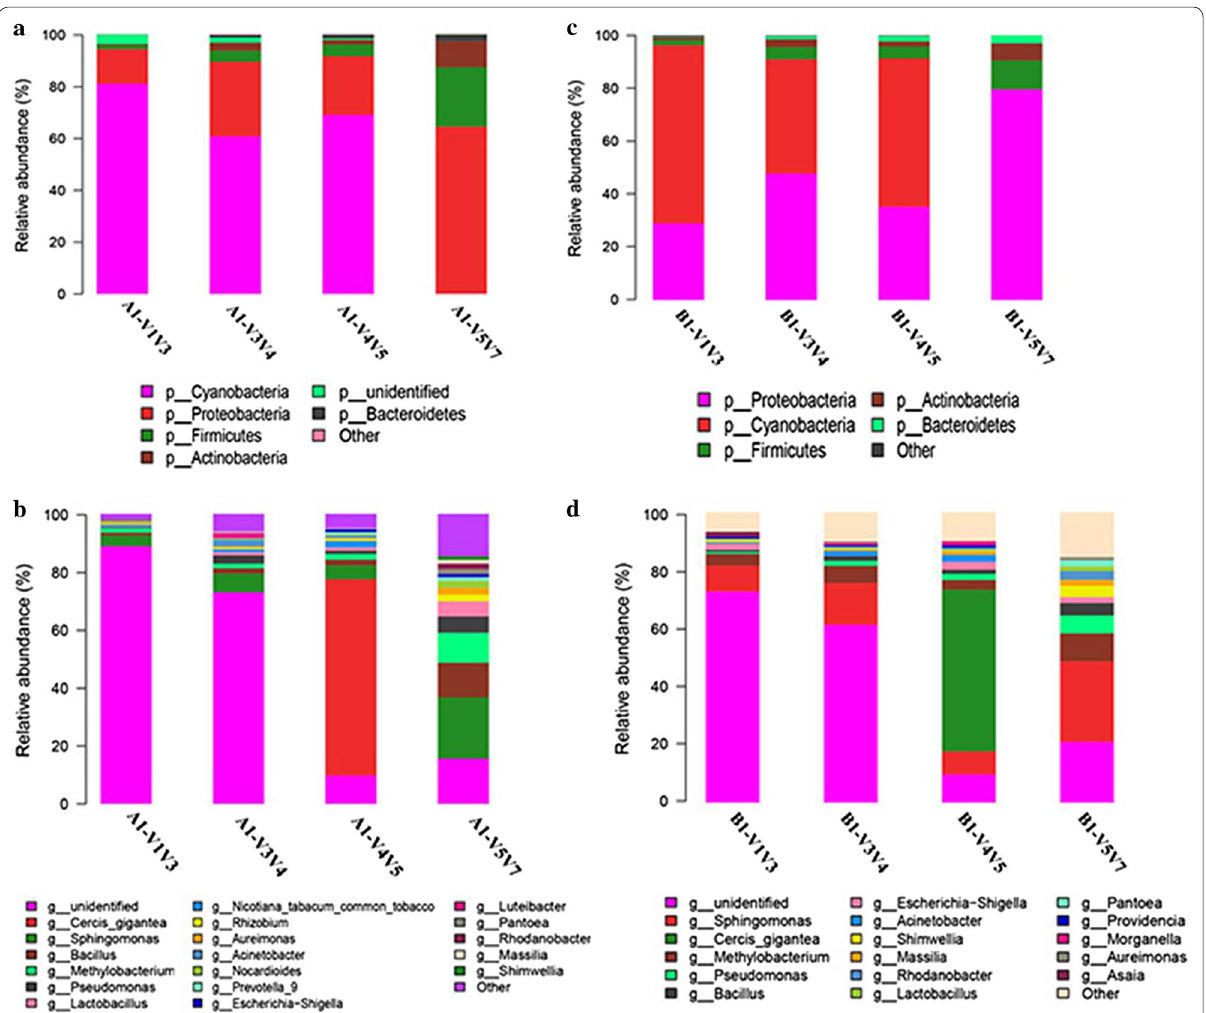
Fig. 2 Relative sequence abundance of bacterial phyla ( a , c ) and genera ( b , d ) associated with different primer sets. Phyla and genera detected as extremely low percentages (< 1%) are not displayed in detail and are summarized as